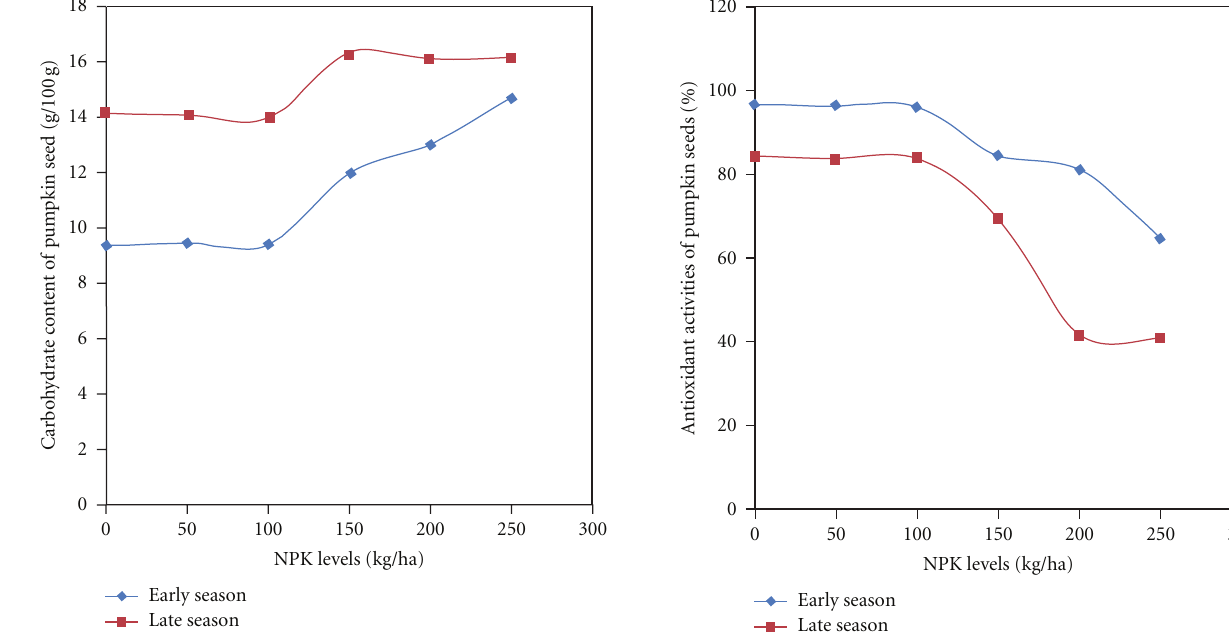
Figure 4: Antioxidant activities of pumpkin seeds as a ff ected by season by NPK fertilizer